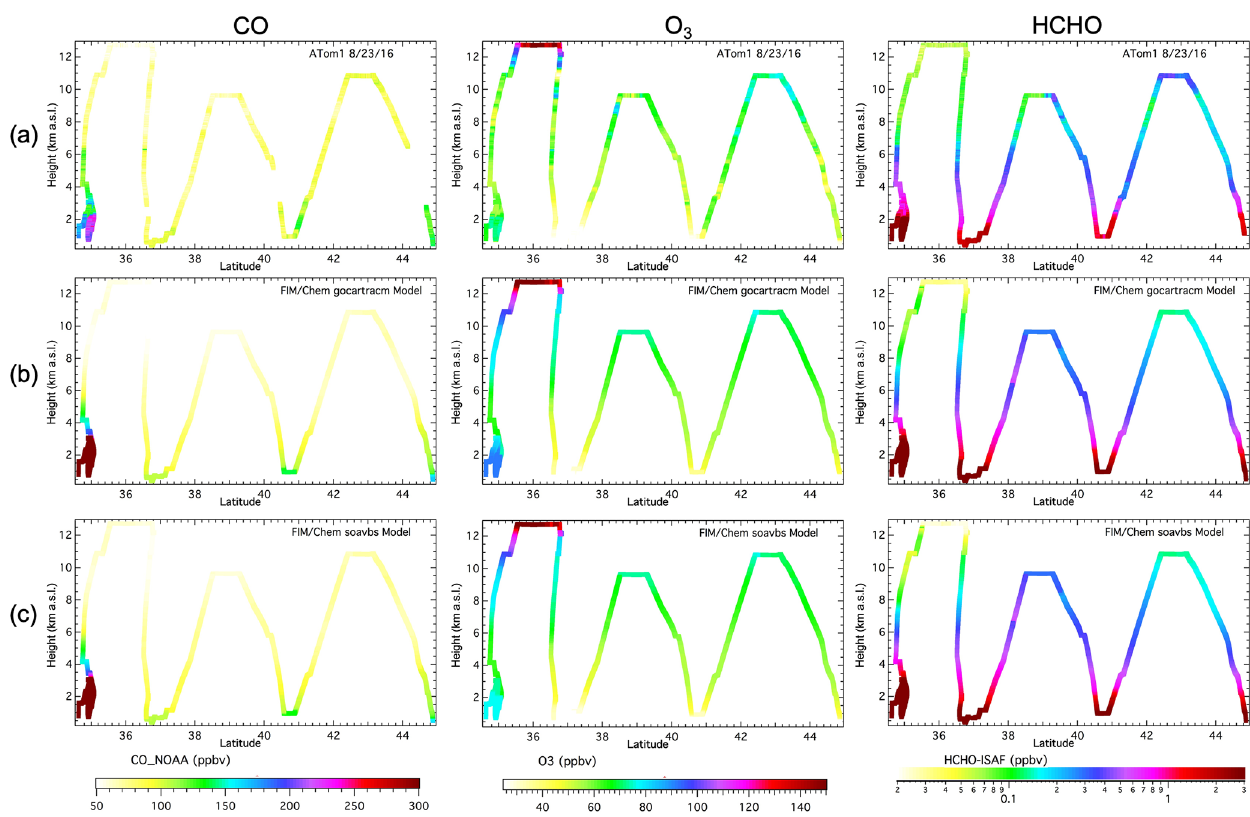
Figure 14. Height–latitude profiles of CO, O 3 , and HCHO over the United States on 23 August 2016 for (a) ATom-1; (b) RACM_GOCART; and (c)